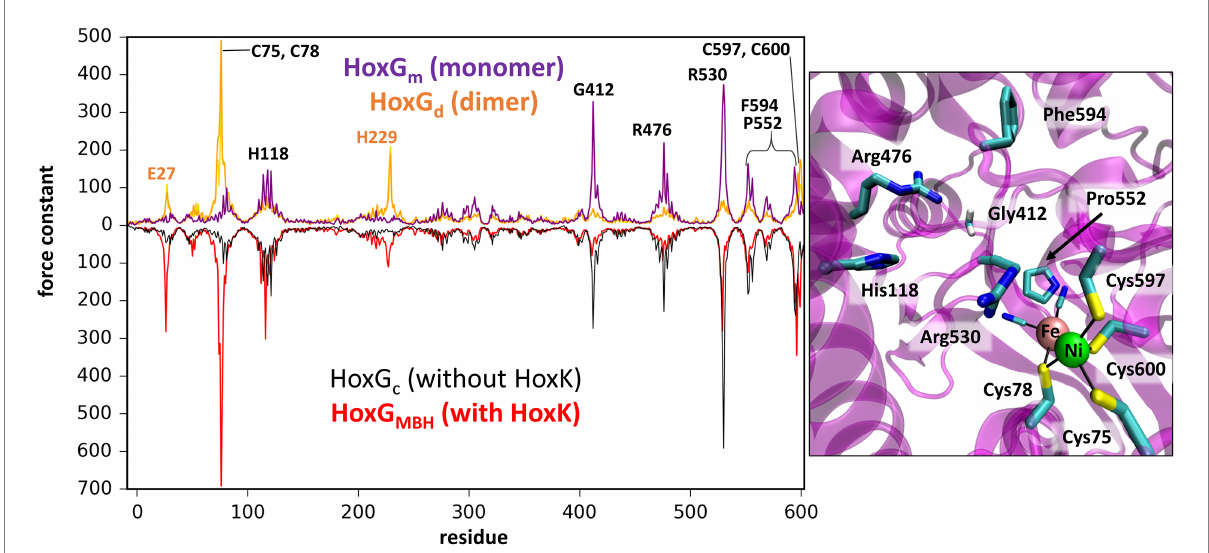
FIGURE 4 Left : Rigidity profiles of HoxG m and HoxG d (upper purple and yellow line, respectively) and HoxG c , HoxG MBH [PDB code: 3RGW (Fritsch et al., 2011); black and red line, respectively]. Force constants (in units kcal·mol − 1 ·Å − 2 ) of HoxG m and HoxG d models were obtained using frames extracted after 200 ns GaMD simulation (simulation 2 in case of HoxG m ). Right : Residues predicted with force constants of 100 kcal·mol − 1 ·Å − 2 or higher in the structures of HoxG m taken from GaMD simulation 2 at 200